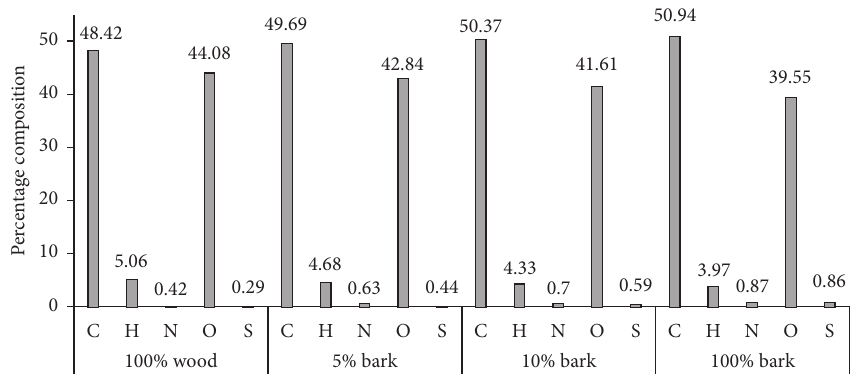
Figure 1: Average elemental composition of the fuelwood